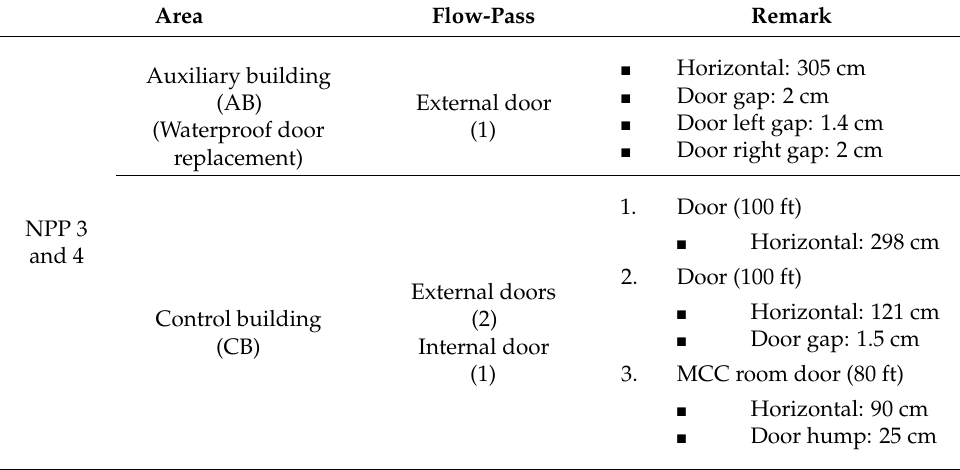
Table 2. Walkdown results of NPPs 3 and